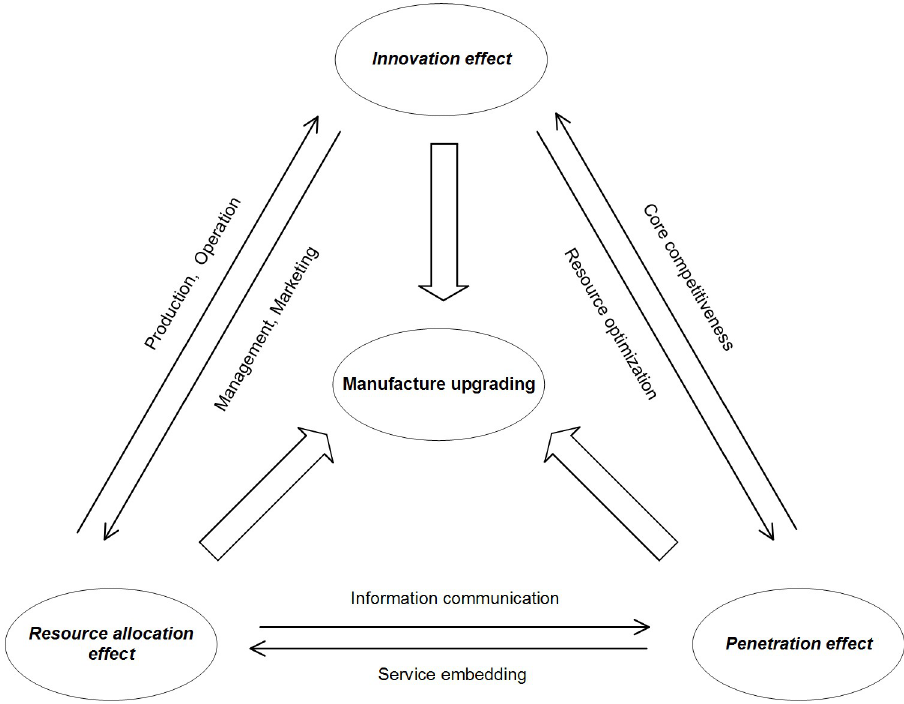
Fig 1. Mechanism of digital technology affecting manufacturing